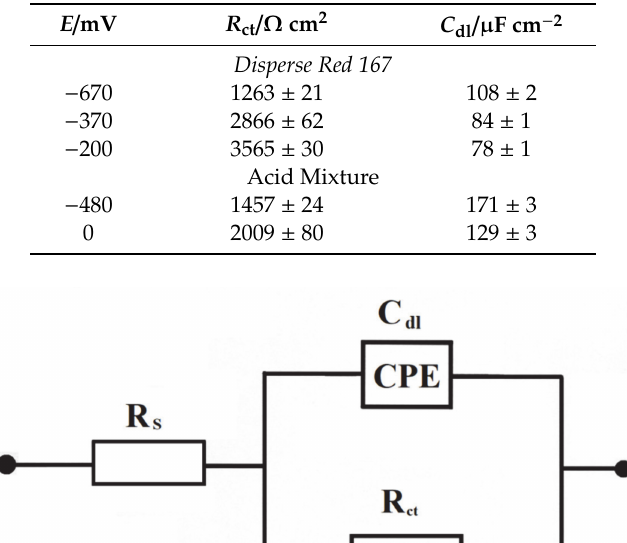
Table 1. Parameters for the process of azo dyes electrooxidation (at a total concentration of 50 mg dm − 3 ) on Al-alloy sacrificial anode in contact with 0.054 M Na 2 SO 4 , achieved by fitting the equivalent circuit